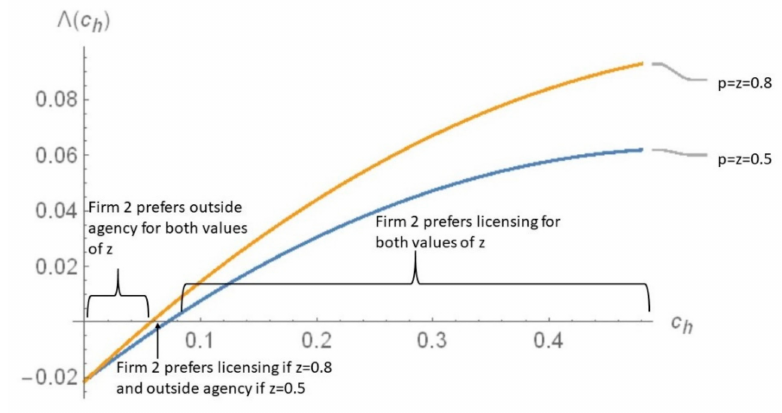
Figure 3. Outside agency vs. licensing for Cases (v) and